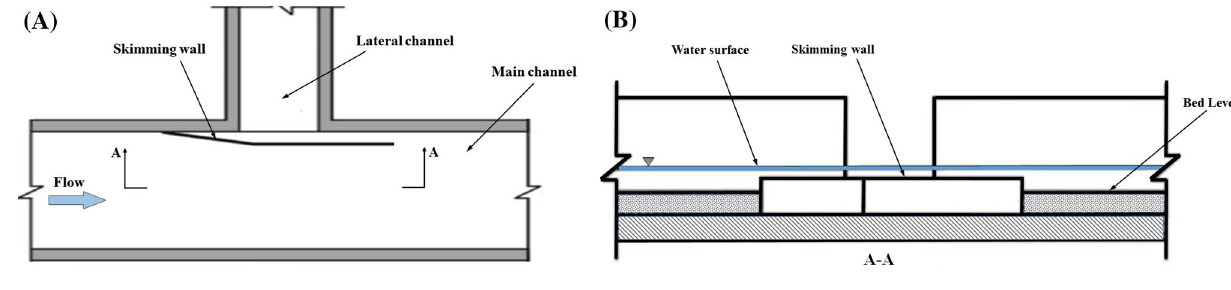
Fig. 1 a Plan view, b cross section of skimming wall (Barkdoll et al.